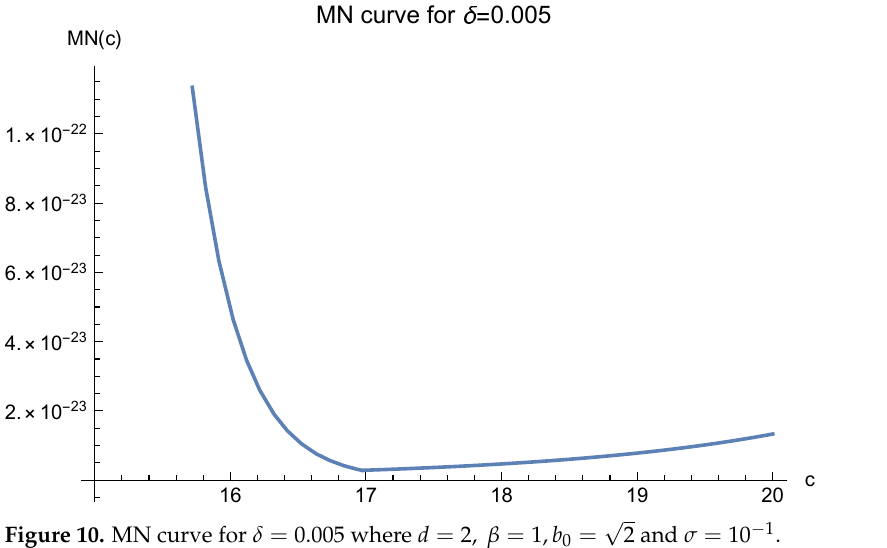
Figure 10. MN curve for δ = 0.005 where d = 2, β = 1, b 0 =